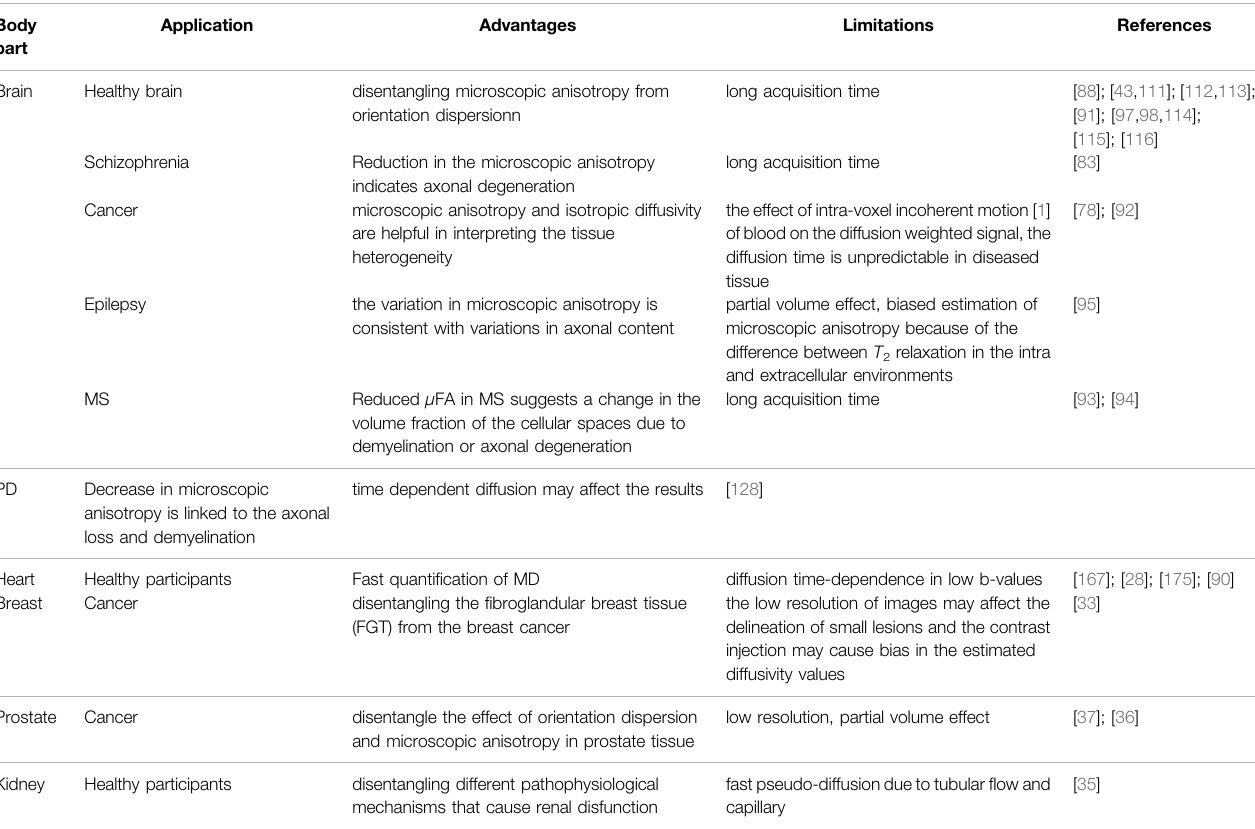
TABLE 1 | Summary of application of tensor-valued diffusion encoding in brain and body imaging. Body